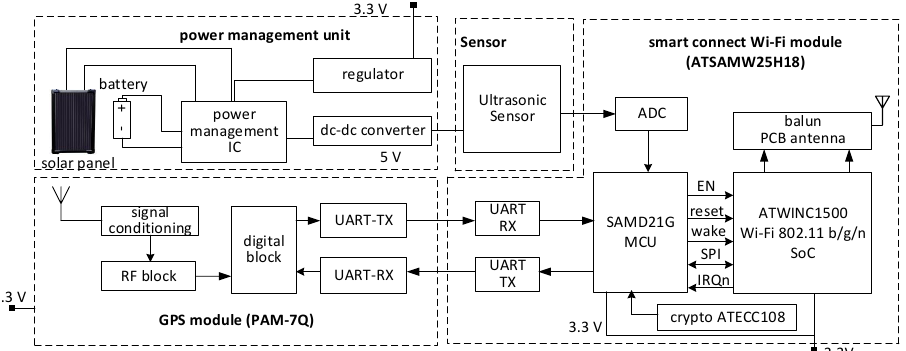
Figure 3. Block diagram of the